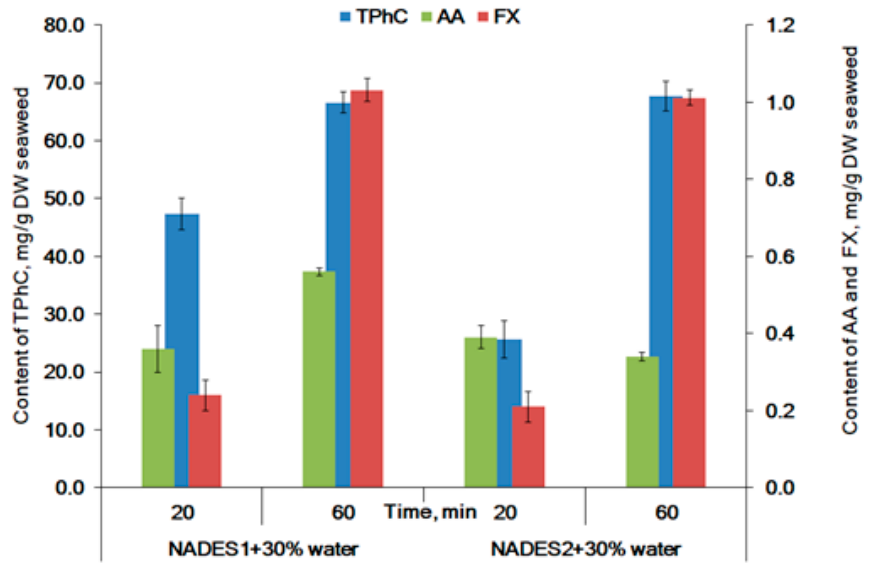
Figure 3. The effect of extraction time on the recovery of ascorbic acid (AA), total phlorotannins (TPhC), and fucoxanthin (FX) from F. vesiculosus by UAE at a 1:10 ( w / v ) seaweed to solvent ratio at 25 °C.